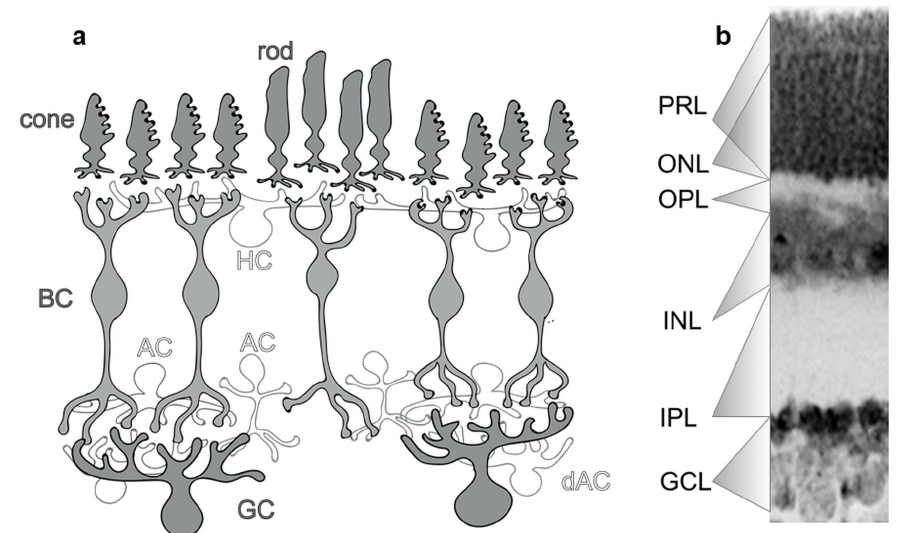
Figure 2. General structure of the mammalian retina. ( a ) The mammalian retina is a structurally complex multi-layered organ built from five major classes of neurons, namely, photoreceptors (PR), bipolar cells (BC) and ganglion cells (GC) that provide parallel pathways; and horizontal (HC) and amacrine cells (AC; and dAC for displaced amacrine cells) which are responsible for maintaining lateral inhibitory synapses in the outer and inner retina, respectively. Based on the localization of each cell type, the retina can be divided into well-defined anatomical layers, including the ganglion cell layer (GCL), the inner plexiform layer (IPL), the inner nuclear layer (INL), the outer plexiform layer (OPL), the outer nuclear layer (ONL) and the photoreceptor layer (PRL). ( b ) These layers are visible on a fluorescent Nissl-stained mouse retinal optical section (whole thickness: 200 µm).